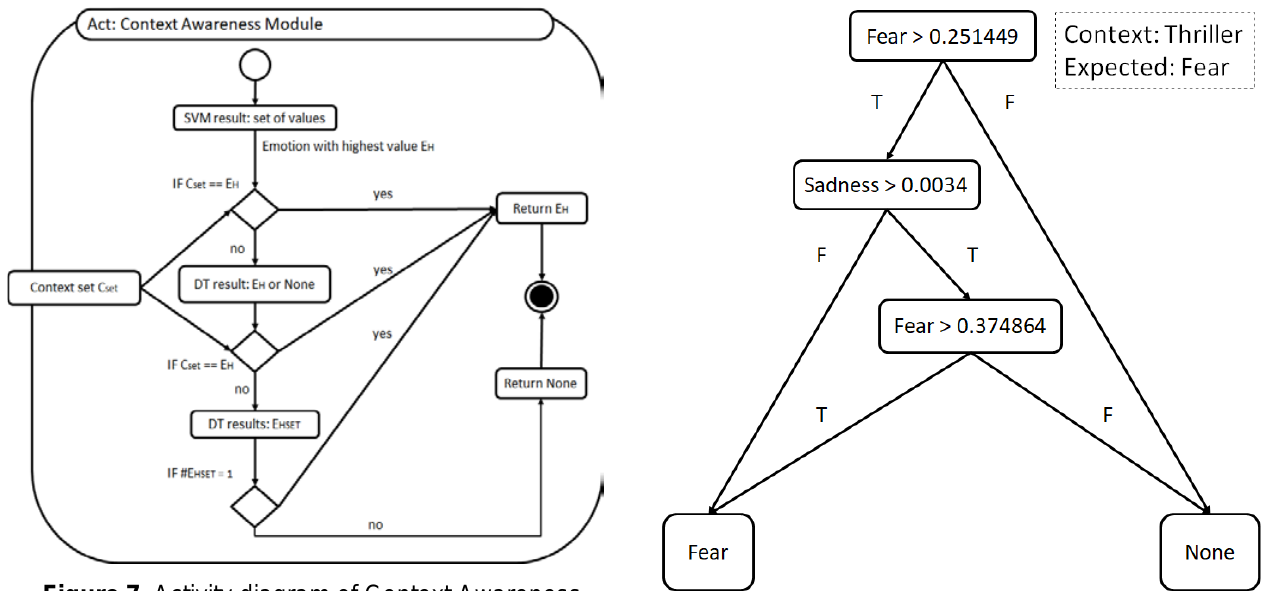
Figure 7. Activity diagram of Context Awareness Module. Figure 8. Fear decision